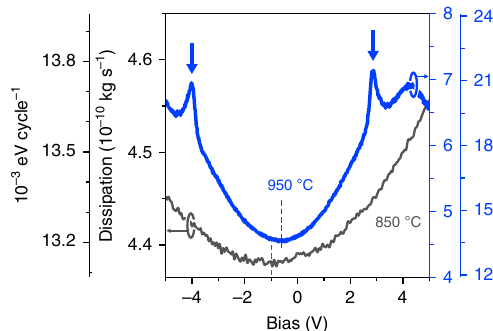
ffiffiffi p ffiffiffi p (cid:3) (cid:4) ´ 5 5